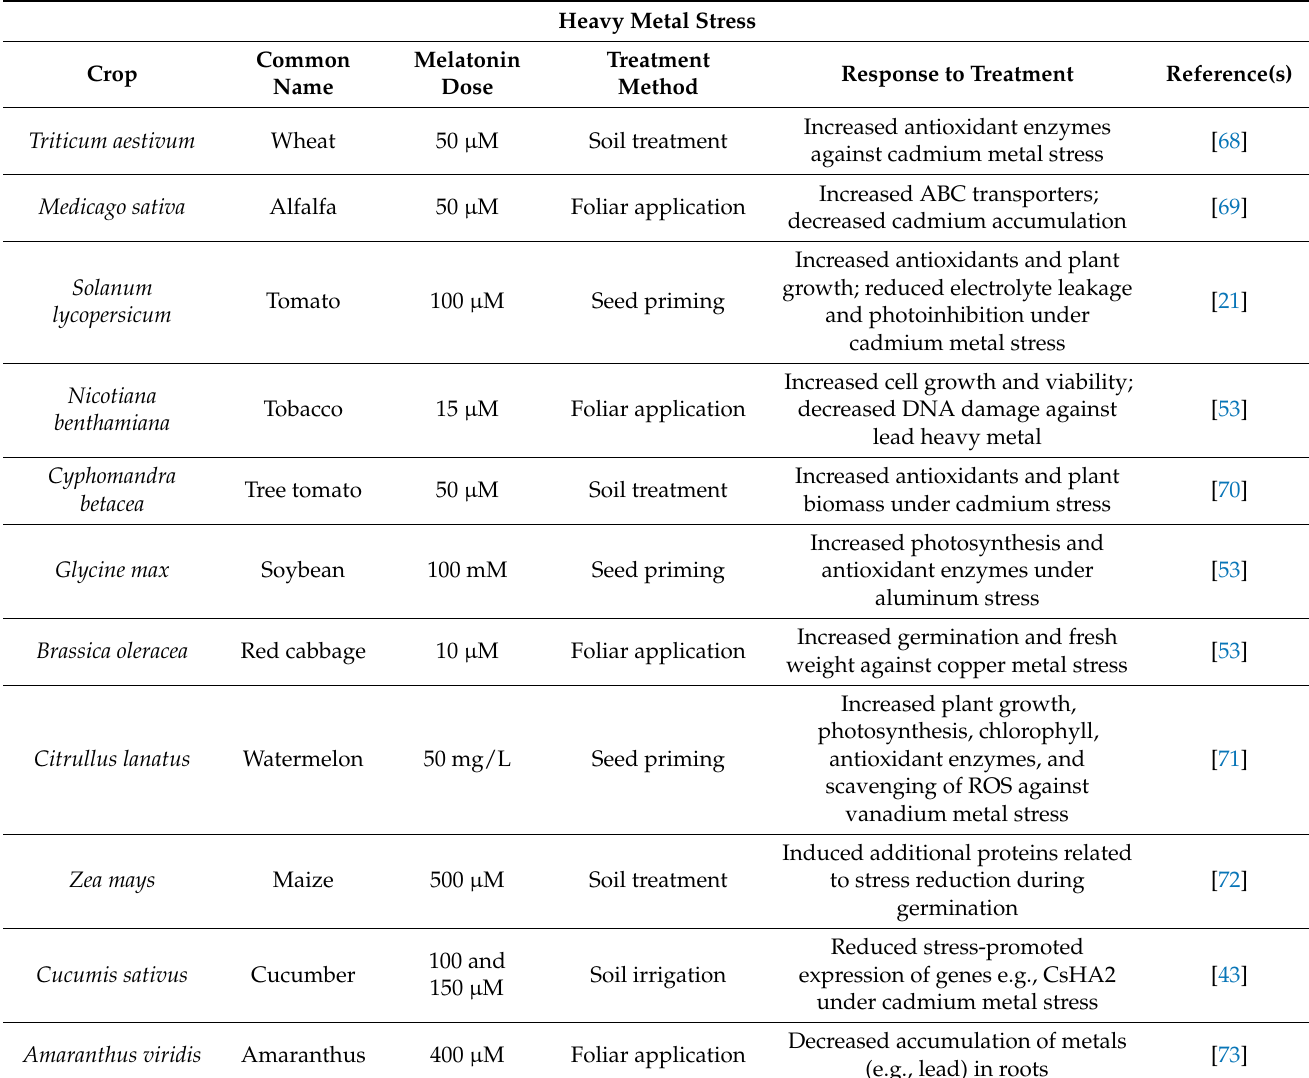
Table 5. Physiological responses of various crops to melatonin treatment against heavy metal